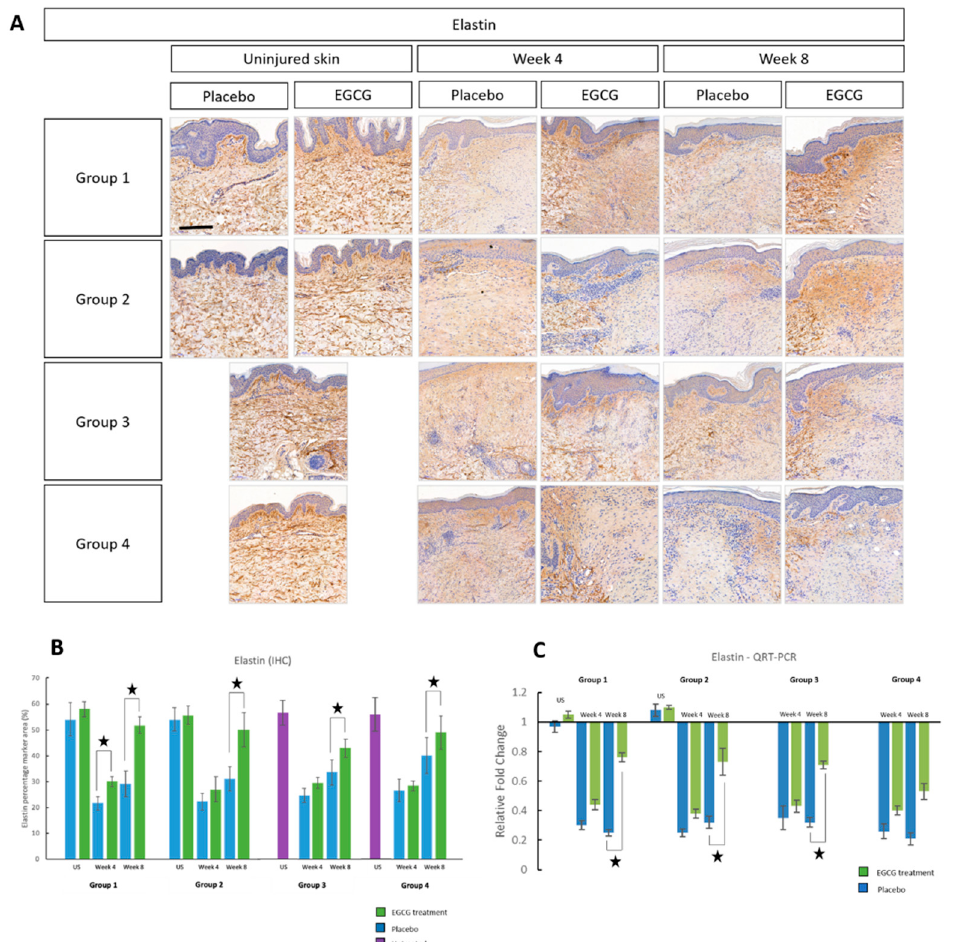
Figure 25. Immunohistochemical analysis of elastin for topical epigallocatechin-3-gallate (EGCG) versus placebo. ( A ) Immunohistochemical images for elastin. ( B ) Elastin percentage marker area measurements. ( C ) Quantitative real-time reverse transcriptase–PCR (QRT-PCR) analysis for elastin. Significance: ★ p ≤ 0.01. Error bars: mean ± SD. Scale bars = 100 μ m.